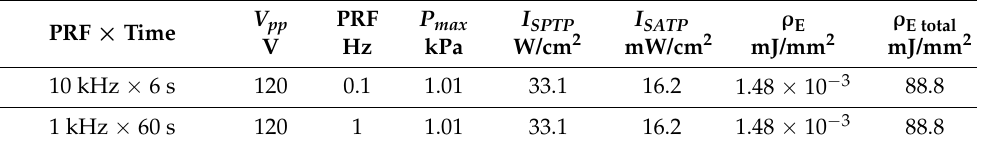
Table 3. Sonication parameters for the short pulse protocols (five cycles of high amplitude P and the same energy density ρ in all cases) with the same total energy in all cases; that is, the same total number of pulses over the total period of sonication: 6 s or 60 s for the pulse repetition frequencies (PRFs) of 10 kHz and 1 kHz, respectively. V pp PRF × Time V